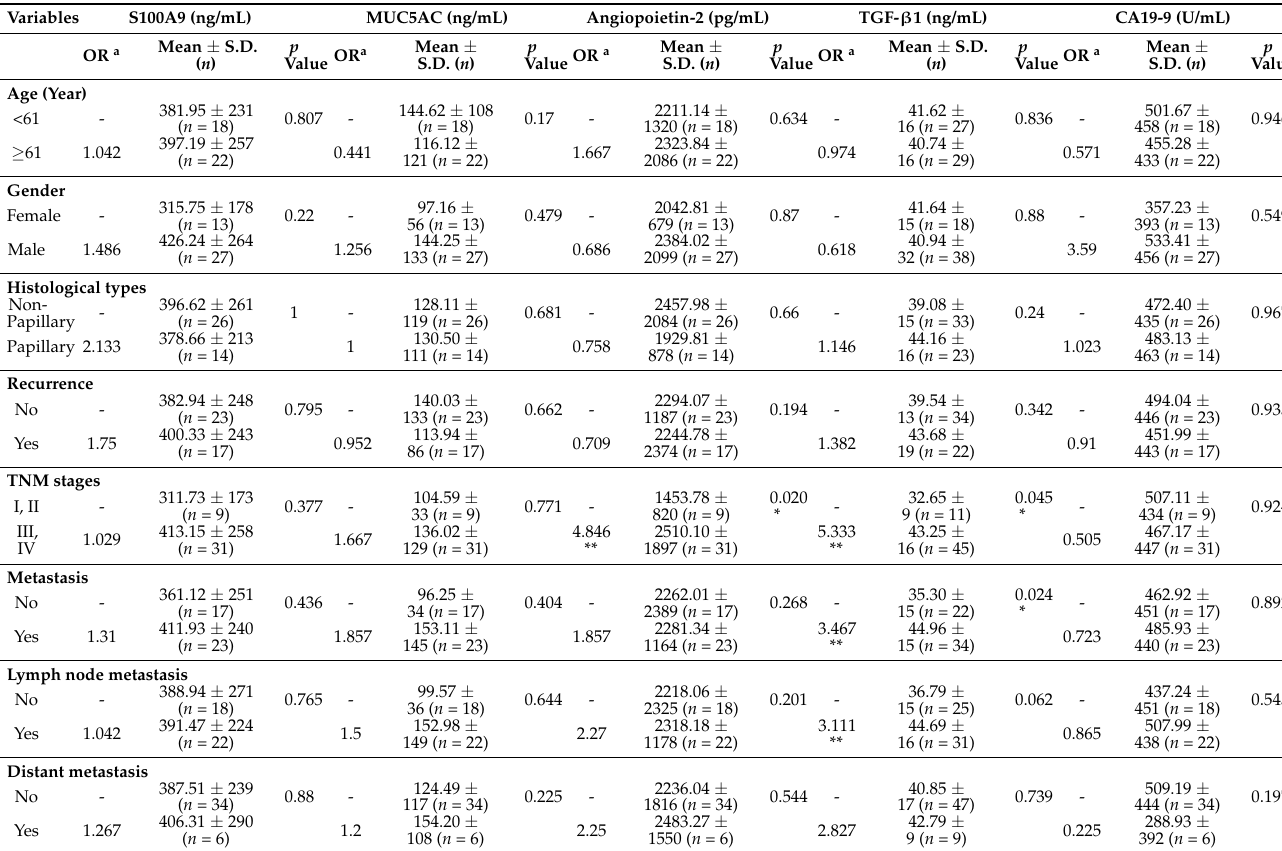
Table 2. The correlation of clinicopathological data and serum levels of candidate biomarkers in CCA